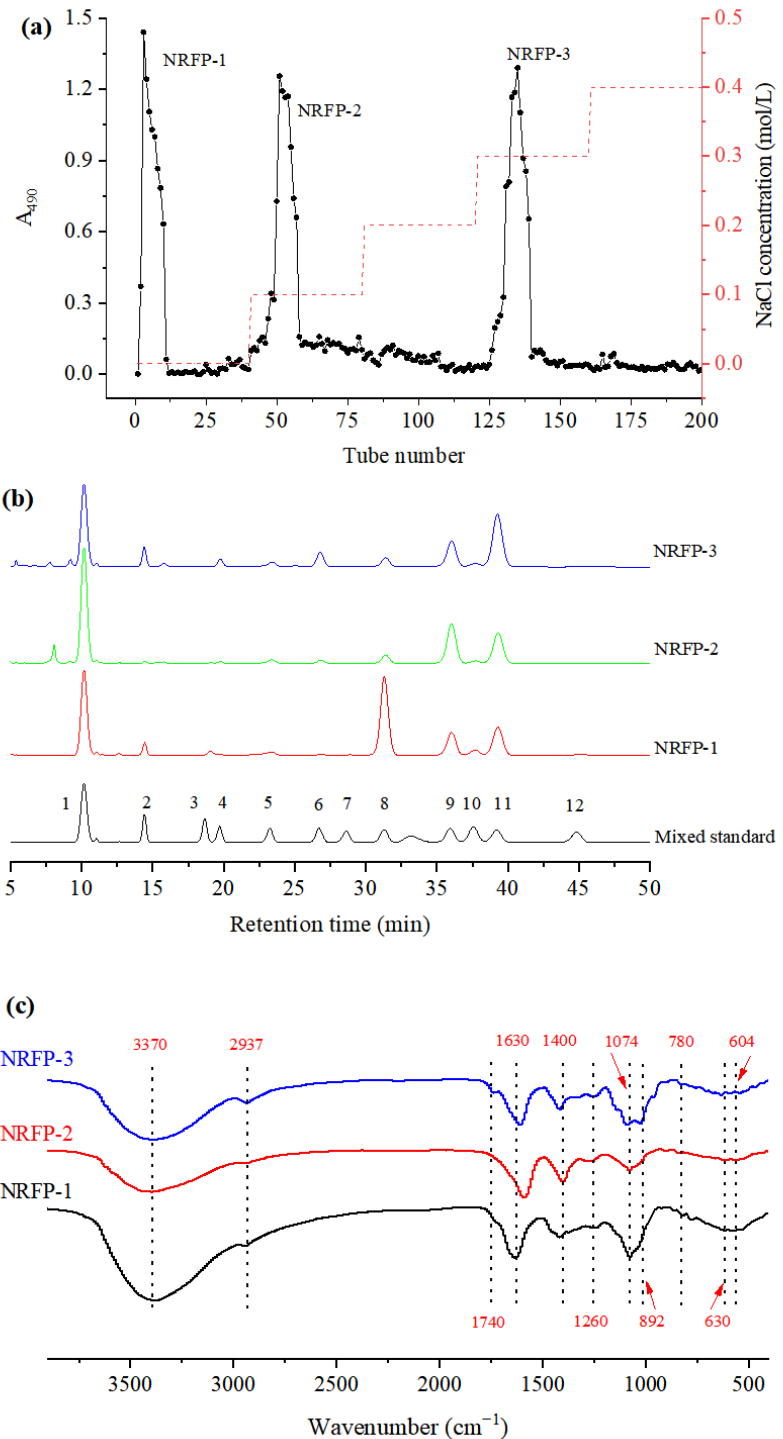
Figure 3. The elution curve ( a ), HPLC chromatograms ( b ), and FT-IR spectrum of NRFPs ( c ). 1: Mannose (Man); 2: Ribose (Rib); 3: Rhamnose (Rha); 4: Glucuronic acid (GluA); 5: Galactose acid (GalA); 6: N-acetyl-amino glucose (N-Glu); 7: Glucose (Glu); 8: N-acetyl-aminogalactose (N-Gal); 9: Galactose (Gal); 10: Xylose (Xyl); 11: Arabinose (Ara); 12: Fucose (Fuc).